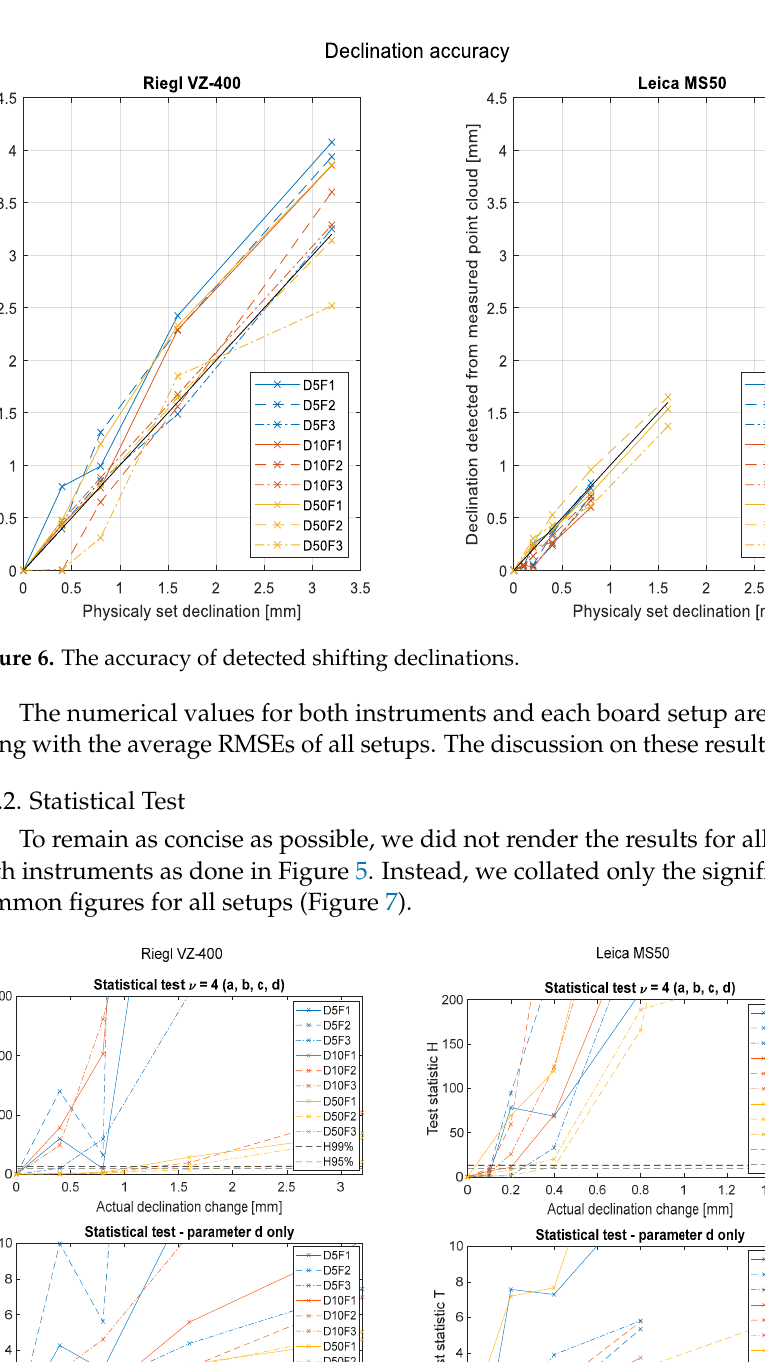
Figure 7. Results of the statistical tests for: ( a ) Riegl VZ-400; ( b ) Leica MS50. Blue lines indicate a distance of 5 m, red lines indicate a distance of 10 m, and yellow lines indicate a distance of 50 m. A full line corresponds to a small incidence angle (I1~0°), a dashed line to an intermediate incidence angle (I2~45°), and a dotted line to large incidence angles (I3~75°). The X axis represents the actual physical declination of the plane and the Y axis represents the values of the test statistics (Equation (5)). The horizontal dashed lines represent the critical values for confidence levels of 95% and 99%.